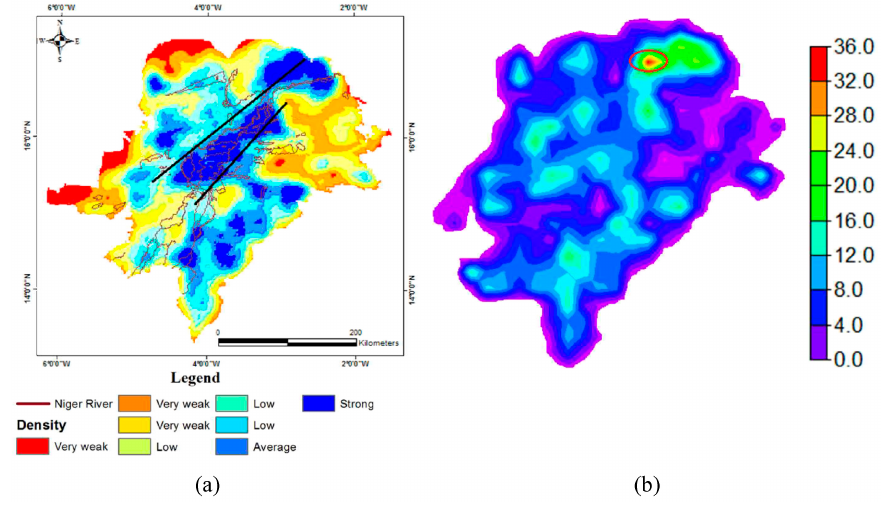
Figure 7. ( a ) Fracture density forming the Center–North corridor; ( b ) Intersection of the